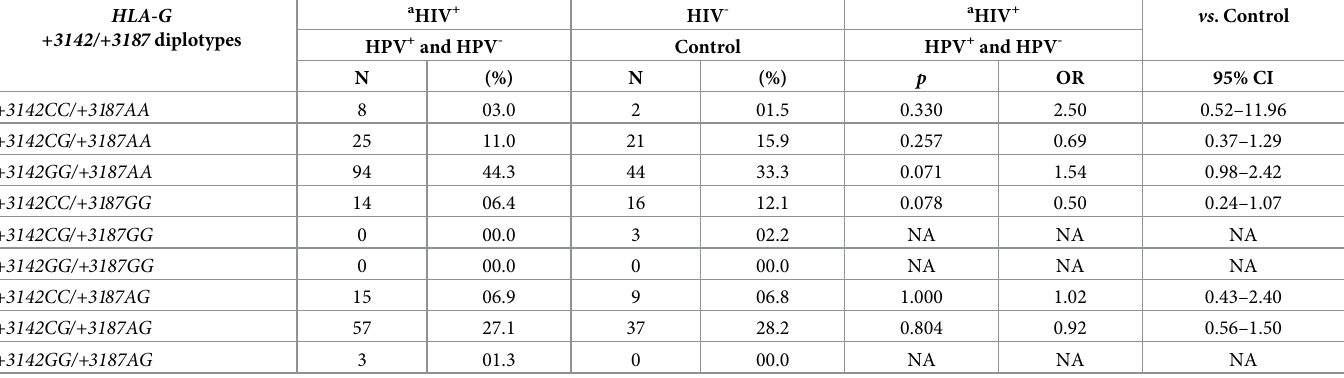
Table 3. Diplotypes frequencies of HLA-G 3’ untranslated region (3’UTR) polymorphic sites of the HLA-G gene in the controls group and in HIV-infected women. HLA-G +3142/+3187 diplotypes